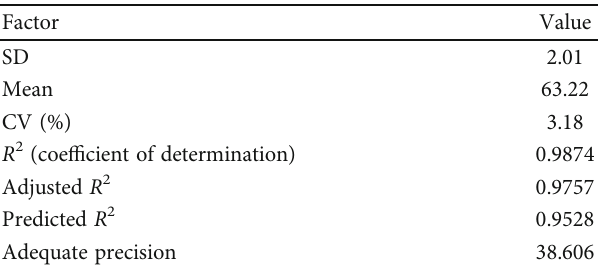
Table 8: Model fi t statistics for the removal of Cr(VI)